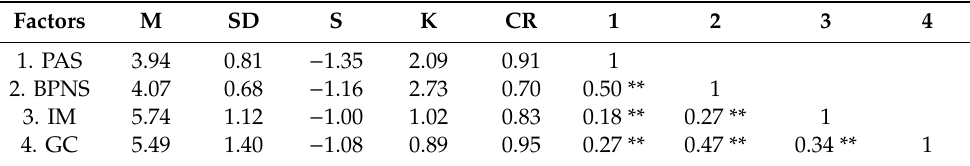
Table 2. Descriptive statistics, composite reliability, and correlations.